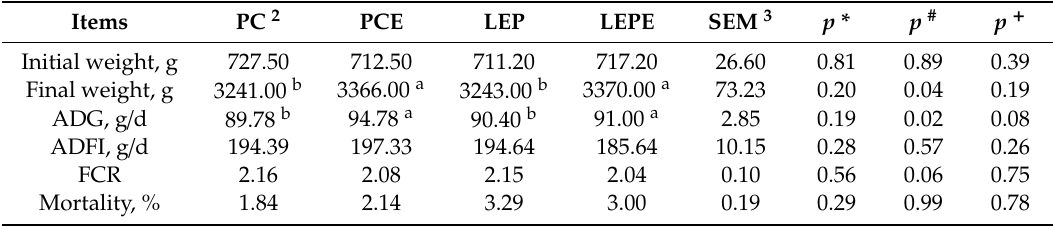
Table 5. E ff ects of protease and phytase in low energy and protein diet on growth performance in ducks 1 .